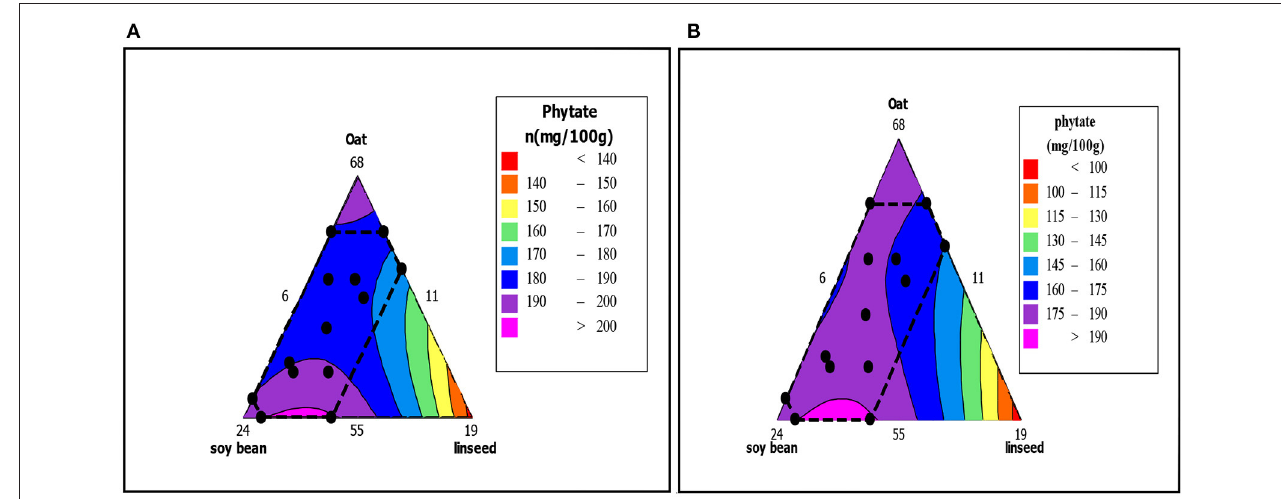
FIGURE 2 | Contour plot of phytate content (mg/100g) extruded (A) and unextruded (B) complementary flour.